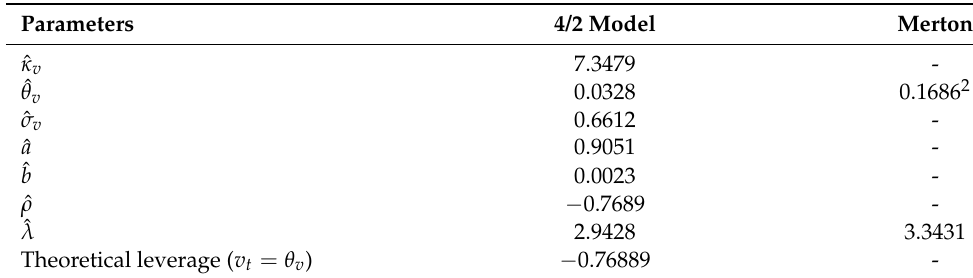
Table 1. Estimates among the various